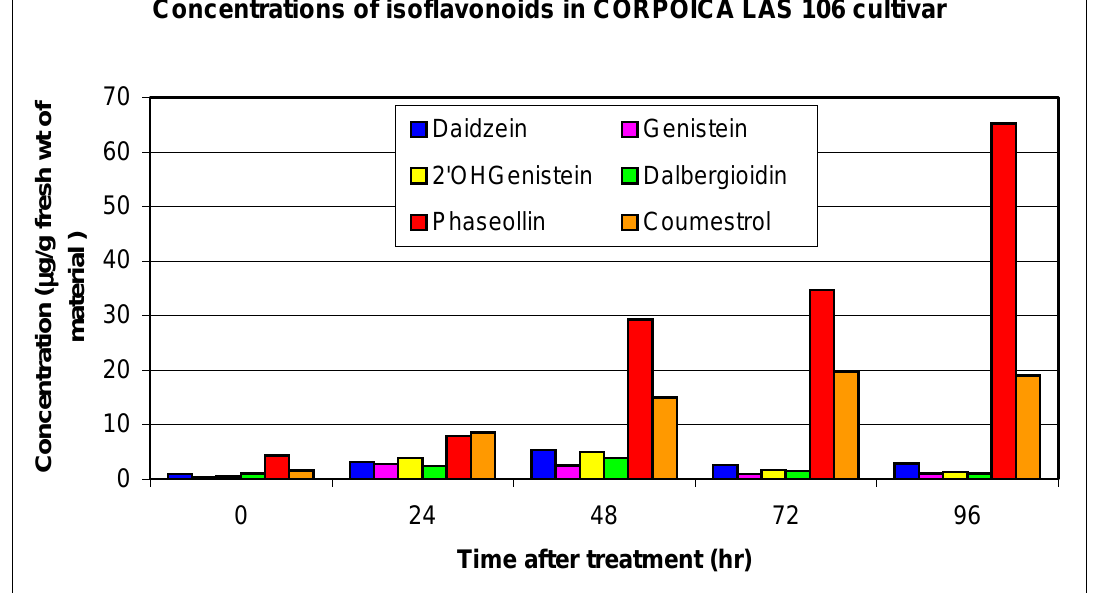
Figure 7. Isoflavonoid contents ( µ g/g. of f. w.) in seedlings of Corpoica LAS 106 bean